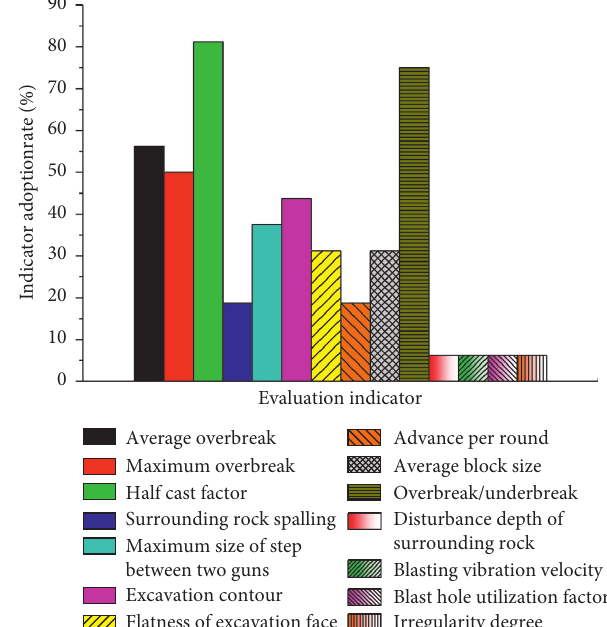
Figure 3: Statistical indices for tunnel contour quality in technical codes.